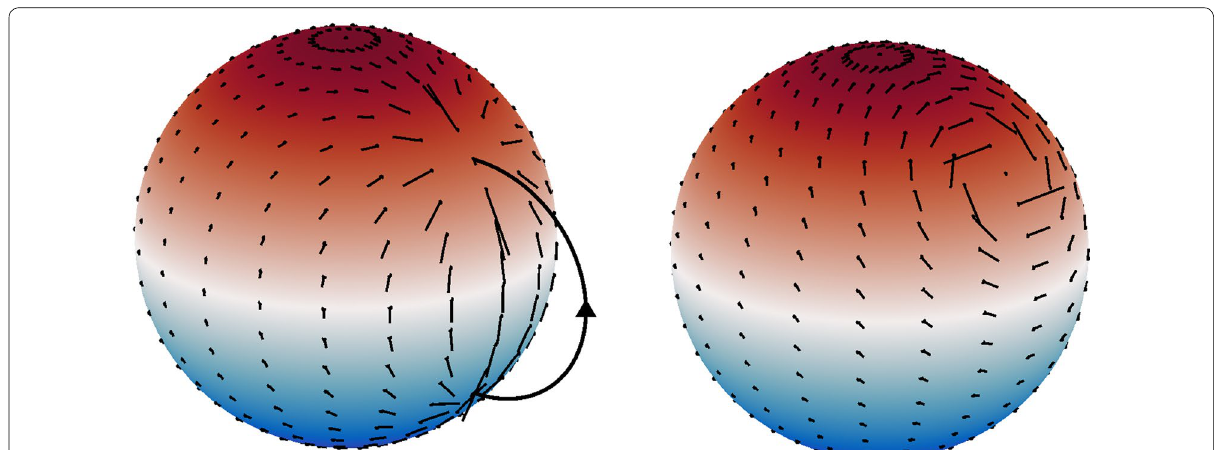
Fig. 1 The current density in the 2D-CF DECS on the left and 2D-DF SECS/DECS on the right. Color represents dipole latitude. In the illustrated case 55 θ 0 =